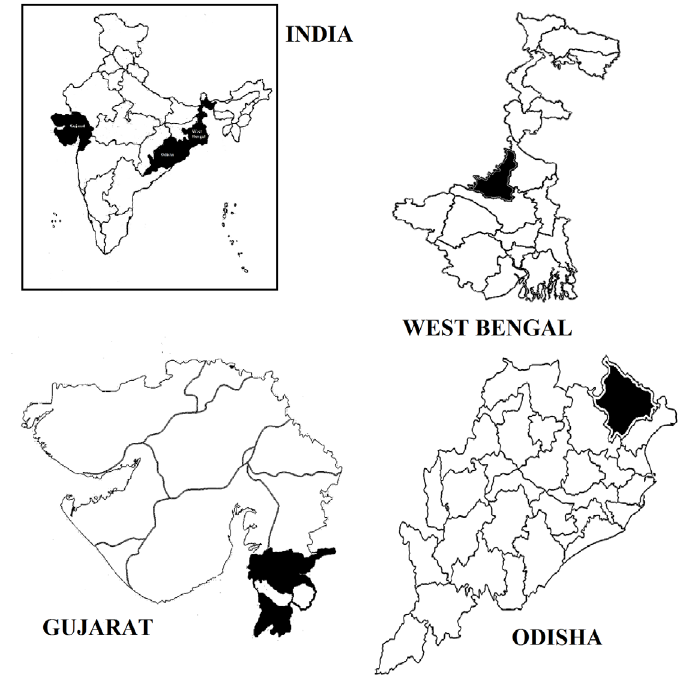
Fig 1. Geographic locations of the selected districts in West Bengal, Odisha and Gujarat on map of India.